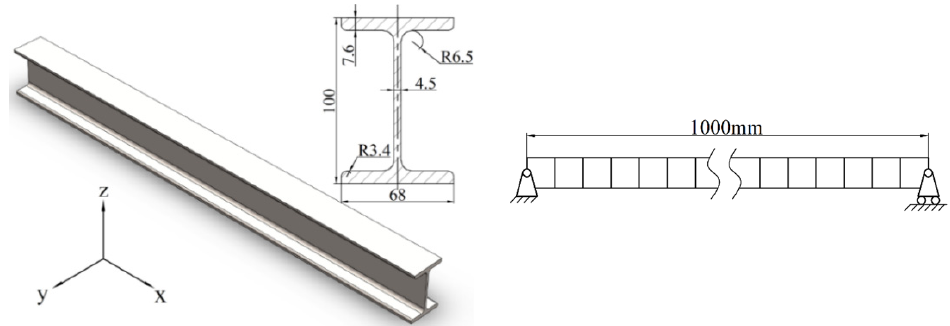
Figure 3. The geometric dimensions of No.10 I-beam ( left ) and its meshing elements ( right ) (unit: mm).